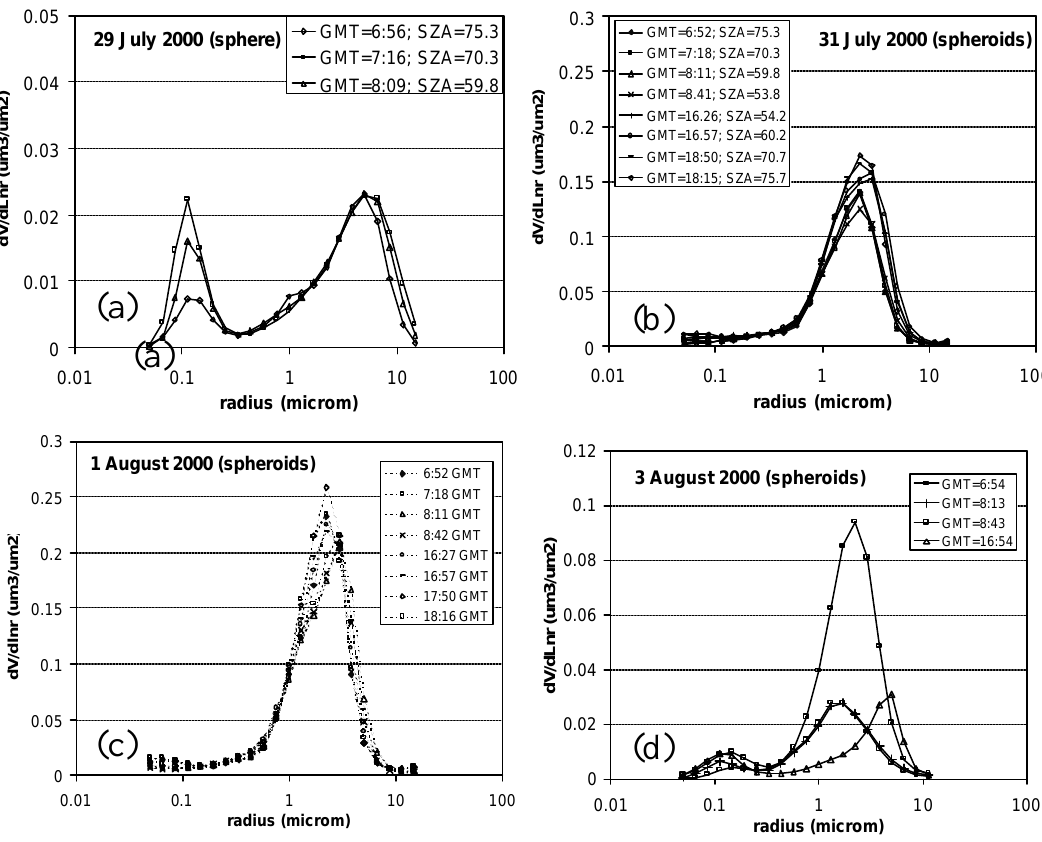
Fig. 9. Volume particle size distribution functions at representative days before, during and after the desert dust event of July–August at El Arenosillo, obtained by inversion of AOD and sky radiance measurements by the CIMEL instrument (AERONET inversion